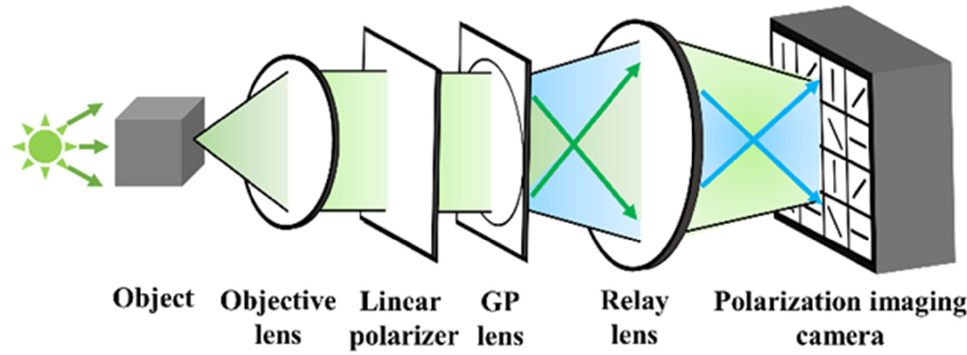
Figure 7. Schematic diagram of the single-shot FINCH system using a GP lens (adapted from [35]).